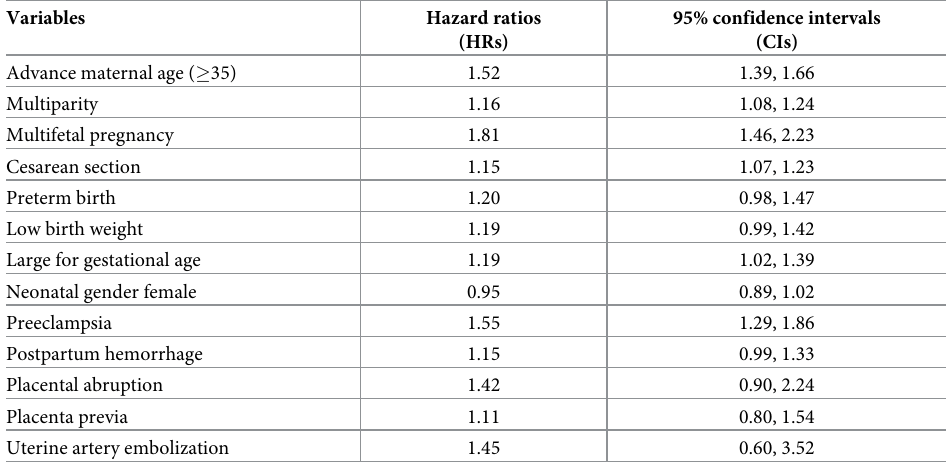
Table 2. Multivariate Cox regression model of the risk of development of endometrial neoplasia. Variables Hazard ratios (HRs)